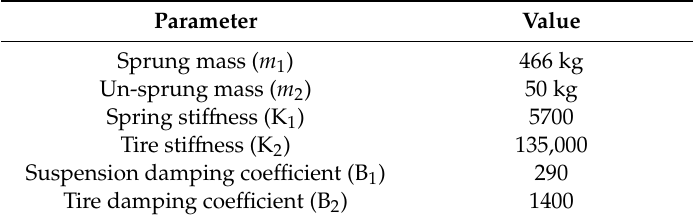
Figure 2. Quarter car suspension model with Eddy Current Damper [17]. Table 2. Mechanical suspension